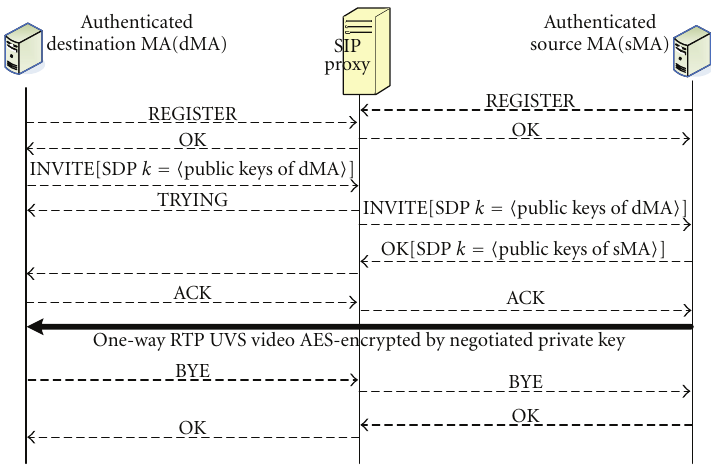
Figure 3: DH key negotiation via SIP/SDP signaling.